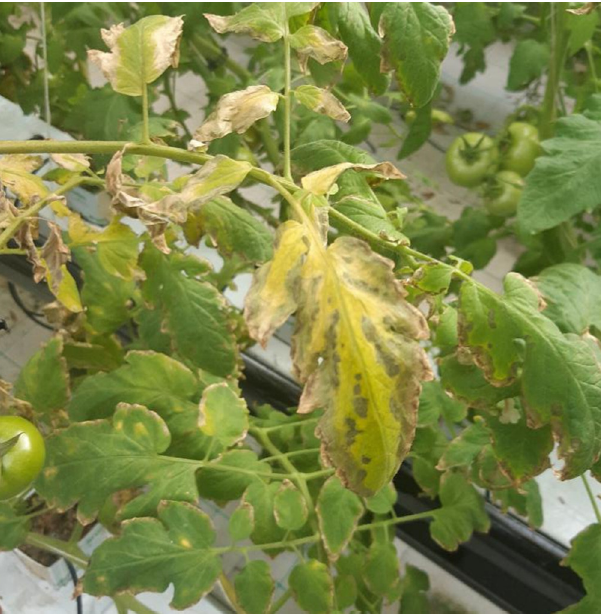
Figure 6. Leaf toxicity symptoms at plants treated with Edypro biostimulants (photo at 89 DAT).